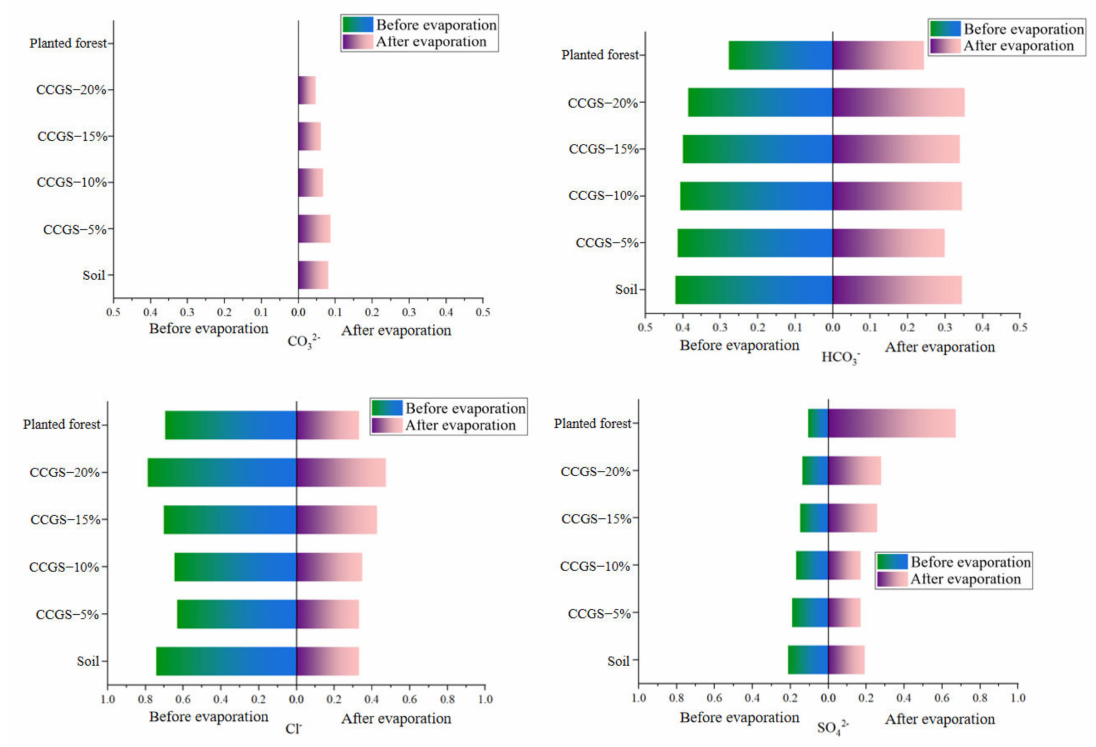
Figure 20. Changes of anions.